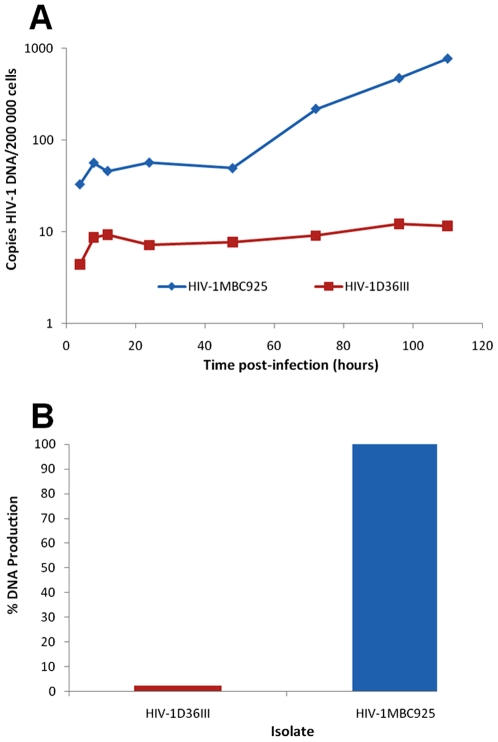
Production of HIV-1 DNA by a reference and a known attenuated virus, quantified using the QPCR assay.PHA-PBMCs were infected with 6 000 pg of p24 of the reference strain HIV-1MBC925 and known attenuated isolate HIV-1D36III, and cultured for 110 h. Infected cells were harvested at 4, 8, 12, 24, 48, 72, 96 and 110 h post-infection. DNA was extracted and the HIV-1 and albumin DNA quantified using QPCR. Copies of HIV-1 DNA per 200 000 cells, determined for each isolate, are plotted on a logarithmic scale against time (A). In (B), relative fitness of HIV-1D36III was determined by calculating the amount of HIV-1 DNA produced at 96 h post-infection, expressed as a percentage of HIV-1MBC925 DNA production at the same time-point. The results are representative of three experiments.